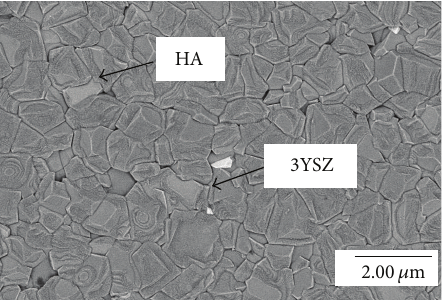
Figure 7: FESEM image of HA/0.5 wt% 3YSZ with nitrogen sinter- ing.